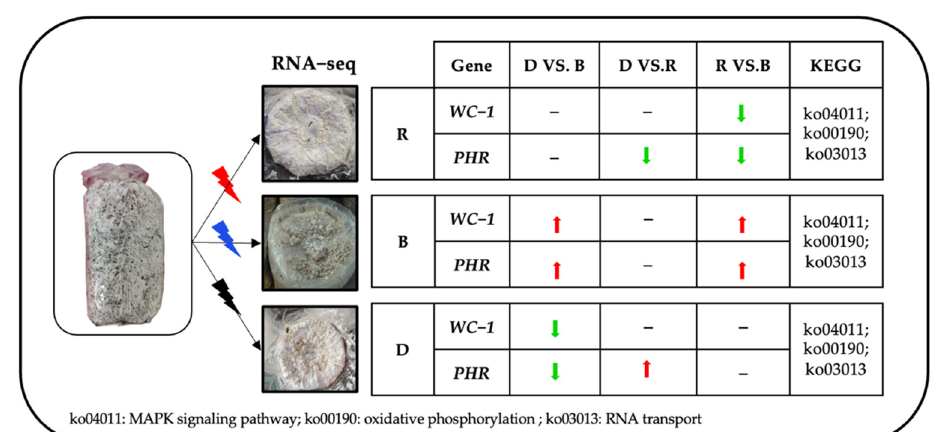
Figure 12. Brief summary.